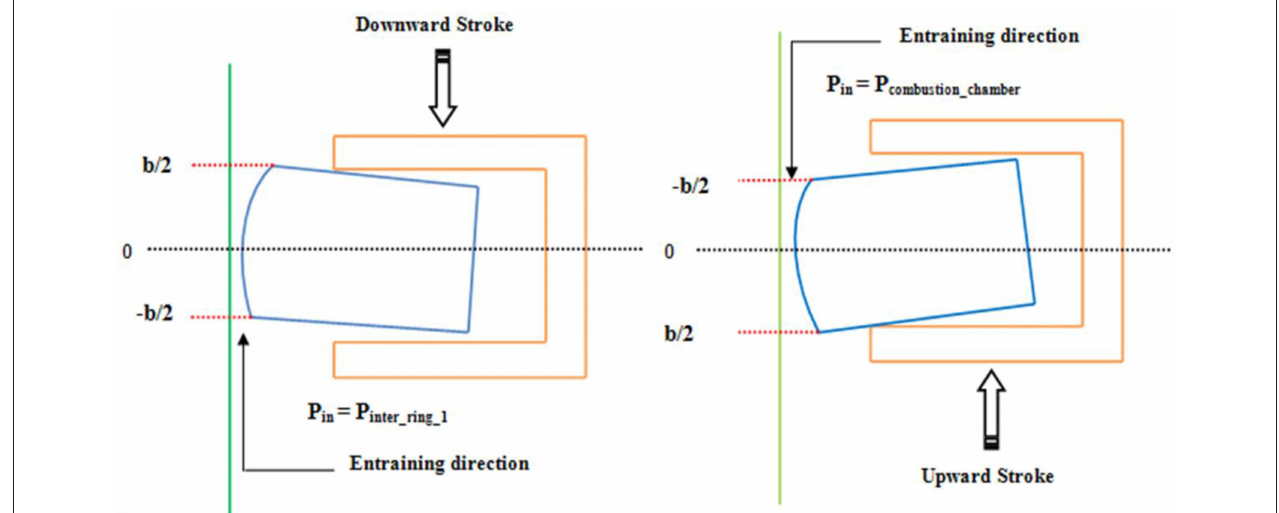
FIGURE 4 | Oil flow and pressure boundary conditions for upward and downward